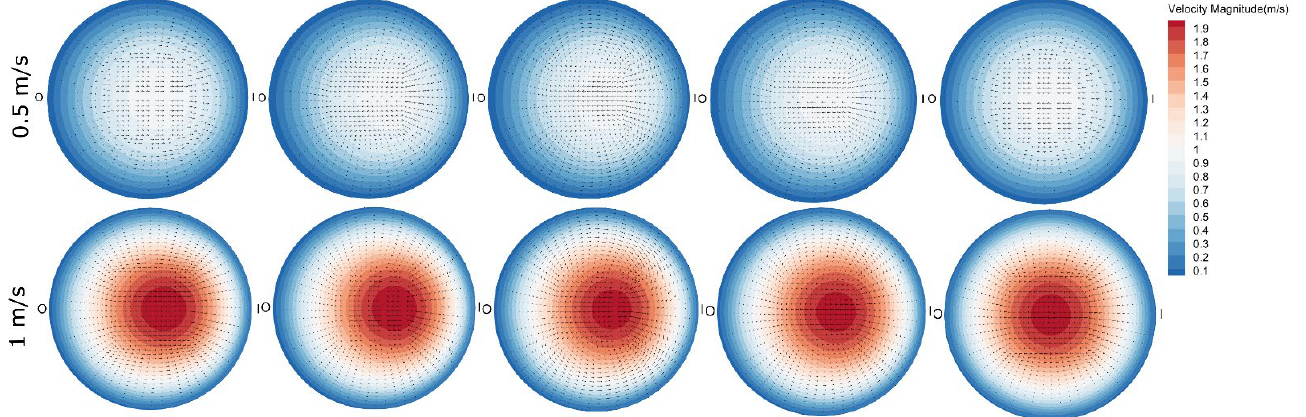
Figure 12. The velocity magnitude and the velocity vectors at the five sections of the U-shaped chan- nel. The first row shows the data at the inlet velocity of 0.5 m/s at the temperature conditions of 283 K on the wall and 300 K of the incoming fluid at the inlet. The lower row shows the results at the inlet velocity of 1 m/s at the temperature conditions of 283 K on the wall and 300 K of the incoming fluid at the inlet.